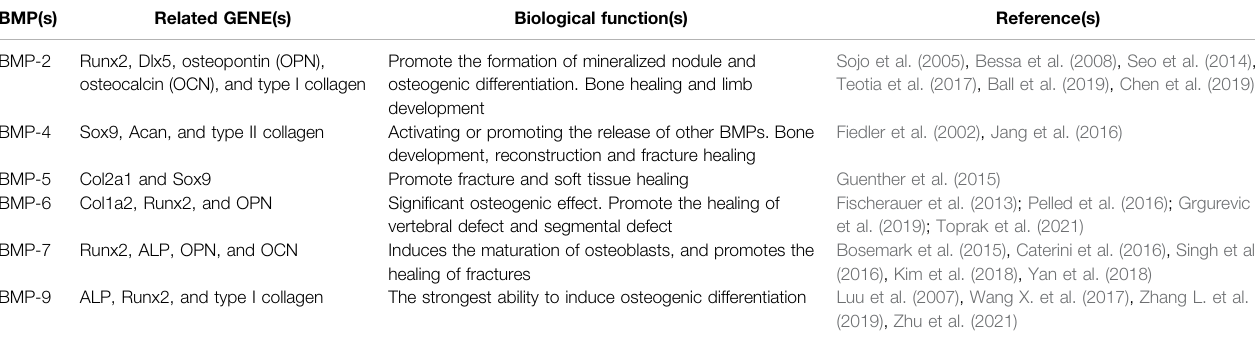
TABLE 2 | Functions of BMPs in bone